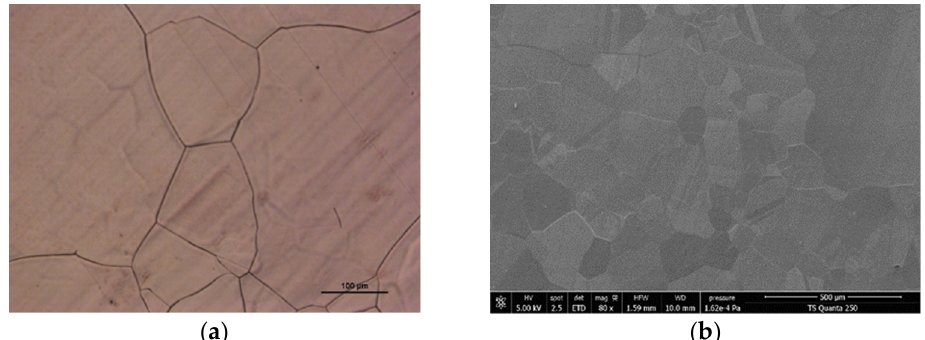
Figure 1. ( a ) Optical micrograph of the surface of the graphene/copper foil, under 20-times magni- fi cation; ( b ) SEM image of graphene/copper foil.